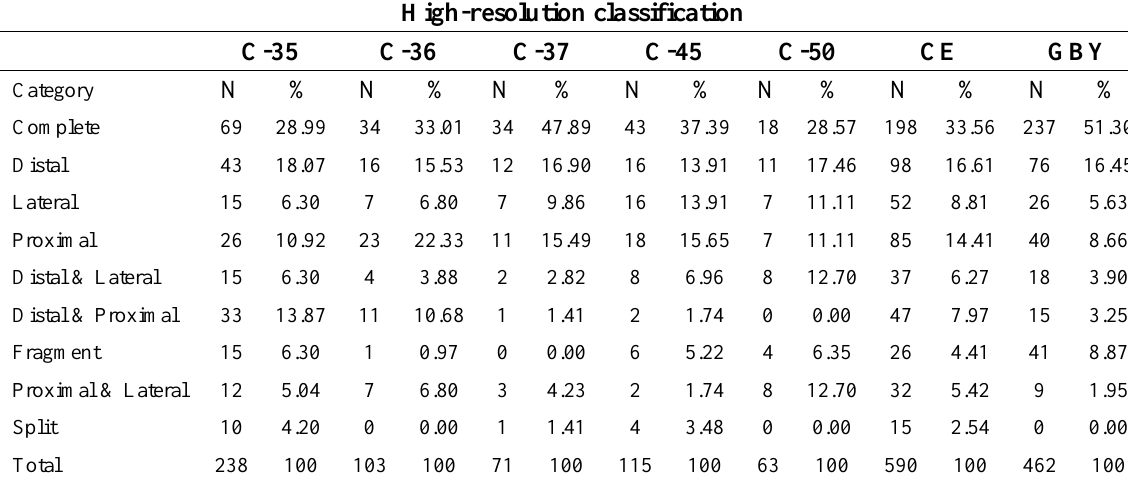
Table 3. High-resolution and hierarchical breakage classifications of experimental and archaeological assemblages. Abbreviations: CE - Combined Experimental; TE - Total